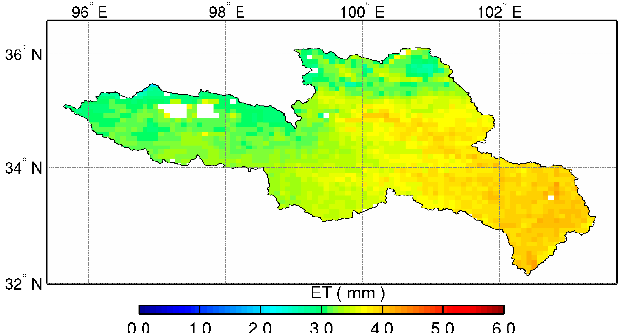
Figure 7. Spatial distribution of daily evapotranspiration (ET) over Northern Tibetan Plateau on August 18th, 2019.